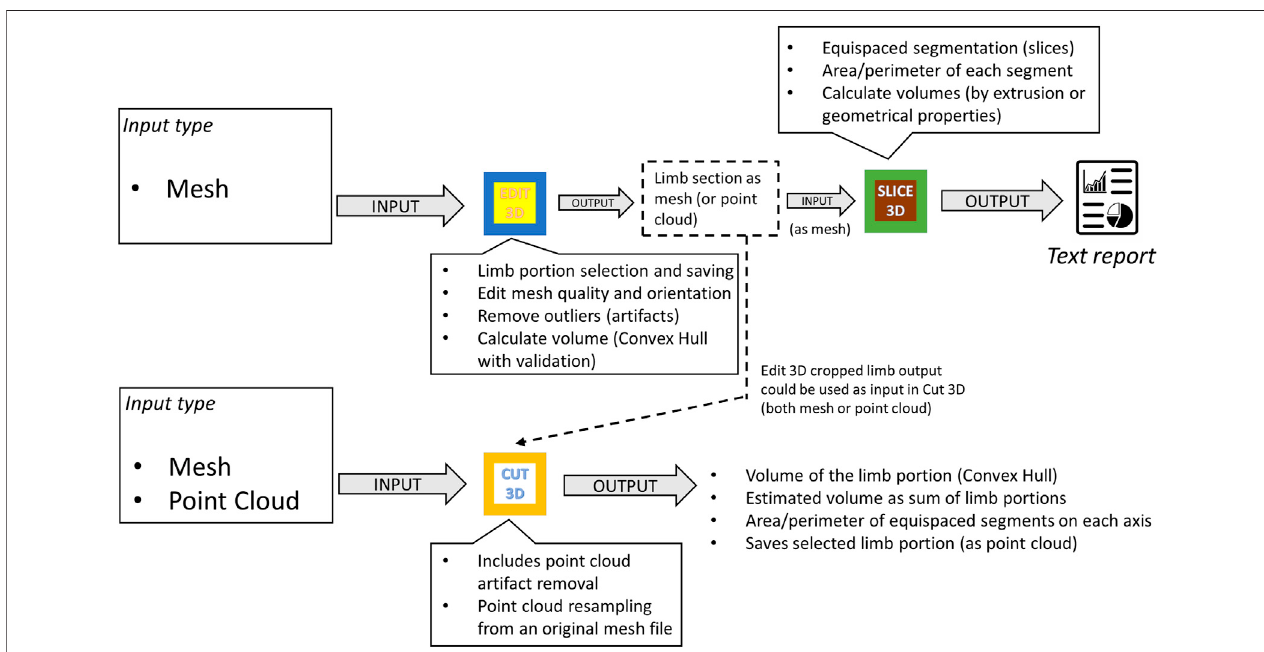
FIGURE 2 | Work fl ow and interaction between software components of the